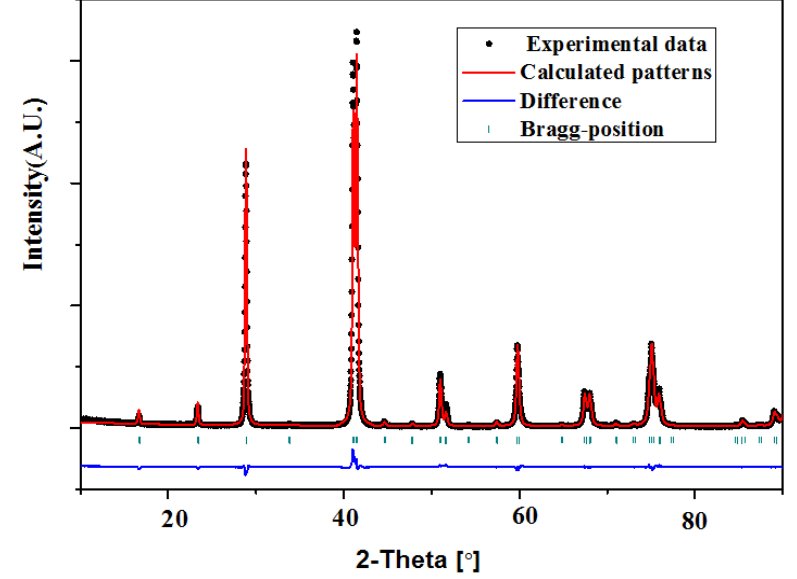
Figure 15. Observed, calculated, and differential XRD patterns of Ni 2 − x Co x In 3 (x = 0.200).